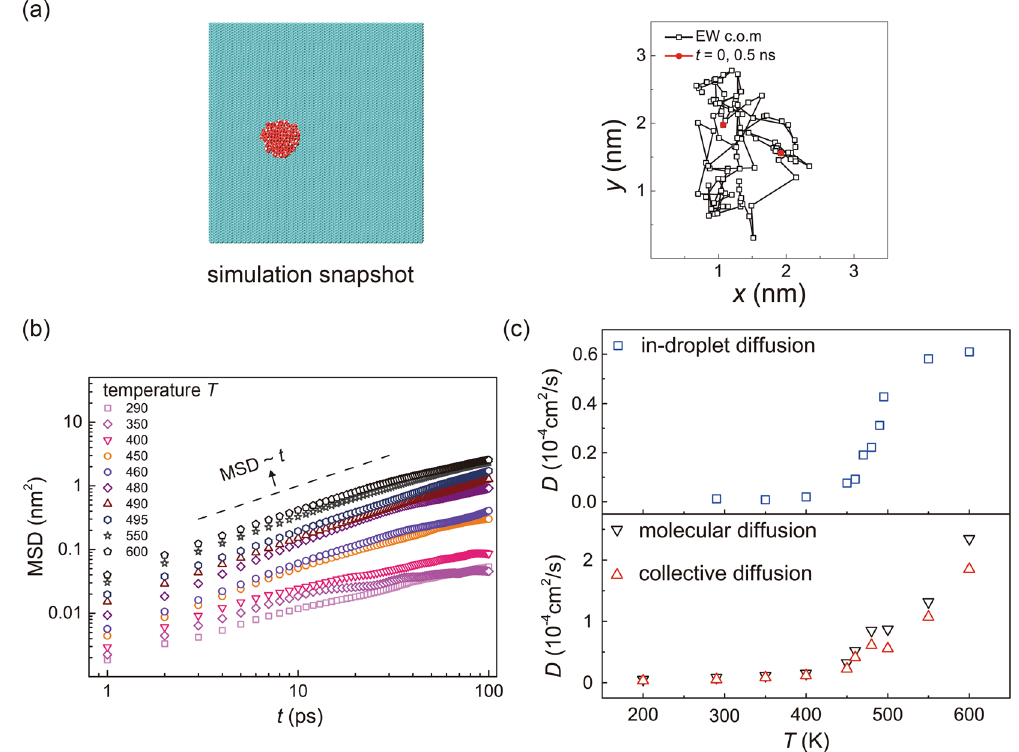
Figure 5. ( a ) A simulation snapshot and a 0.5 ns-long center-of-mass trajectory of the encapsulated water with N W = 115, at T = 300 K. Here only the graphene substrate is shown. ( b ) MSD of water molecular diffusion in a monolayer EW, calculated at different temperature. ( c ) Diffusion coefficient D calculated for both molecular diffusion and the collective diffusion of EW. To calculate the in-droplet diffusion, the collective motion is subtracted from molecular